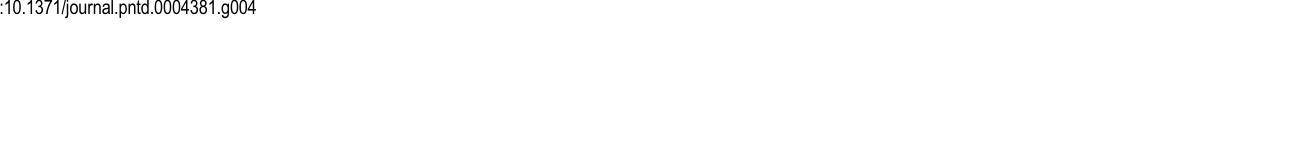
Fig 4. Example background similarity tests showing overall niche overlap between ecological niche models for pairs of species: (A) Leishmania major — Phlebotomus papatasi and (B) Leishmania major – Meriones libycus . The vertical purple line shows observed niche overlap, and the histograms show the distribution of the background similarity values among 100 random replicates, for the I and D similarity metrics. On the maps, red and blue shading indicates the modeled suitable areas for the two species; purple shading shows areas of overlap between the two species. Results for other species are given in the Supporting Information (S5